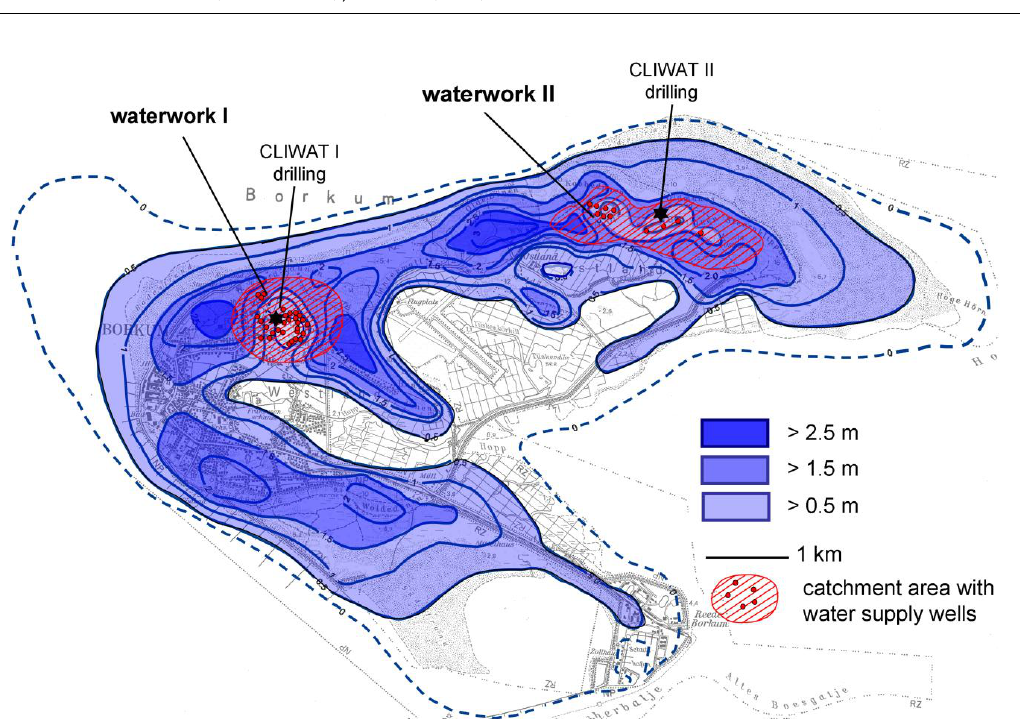
Fig. 3. Groundwater table of the upper aquifer during March 2010 (water supply wells marked by red circles, location of CLIWAT drillings marked by black stars, mean sea level marked by dashed line).